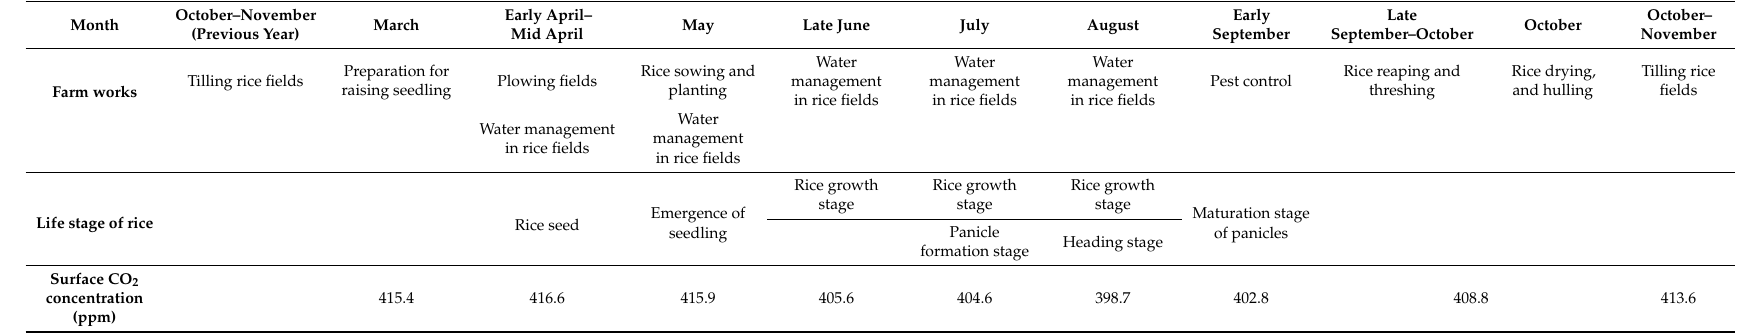
Table A7. General annual farm work schedule and corresponding rice life stages in farmlands of central Akita Prefecture (based on [48,49]) and simulated CO 2 concentrations (from [33]).